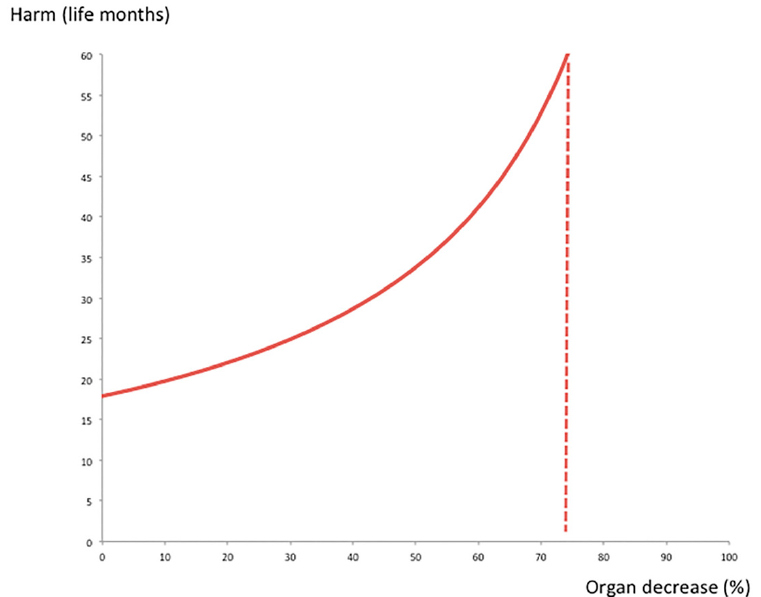
Figure 2. Sensitivity analysis applied to the Markov model. Impact of a decrease (%) in organ availability on the aggregate harm (months) to others on the waiting list due to individual organ allocation in T2 HCC patients.